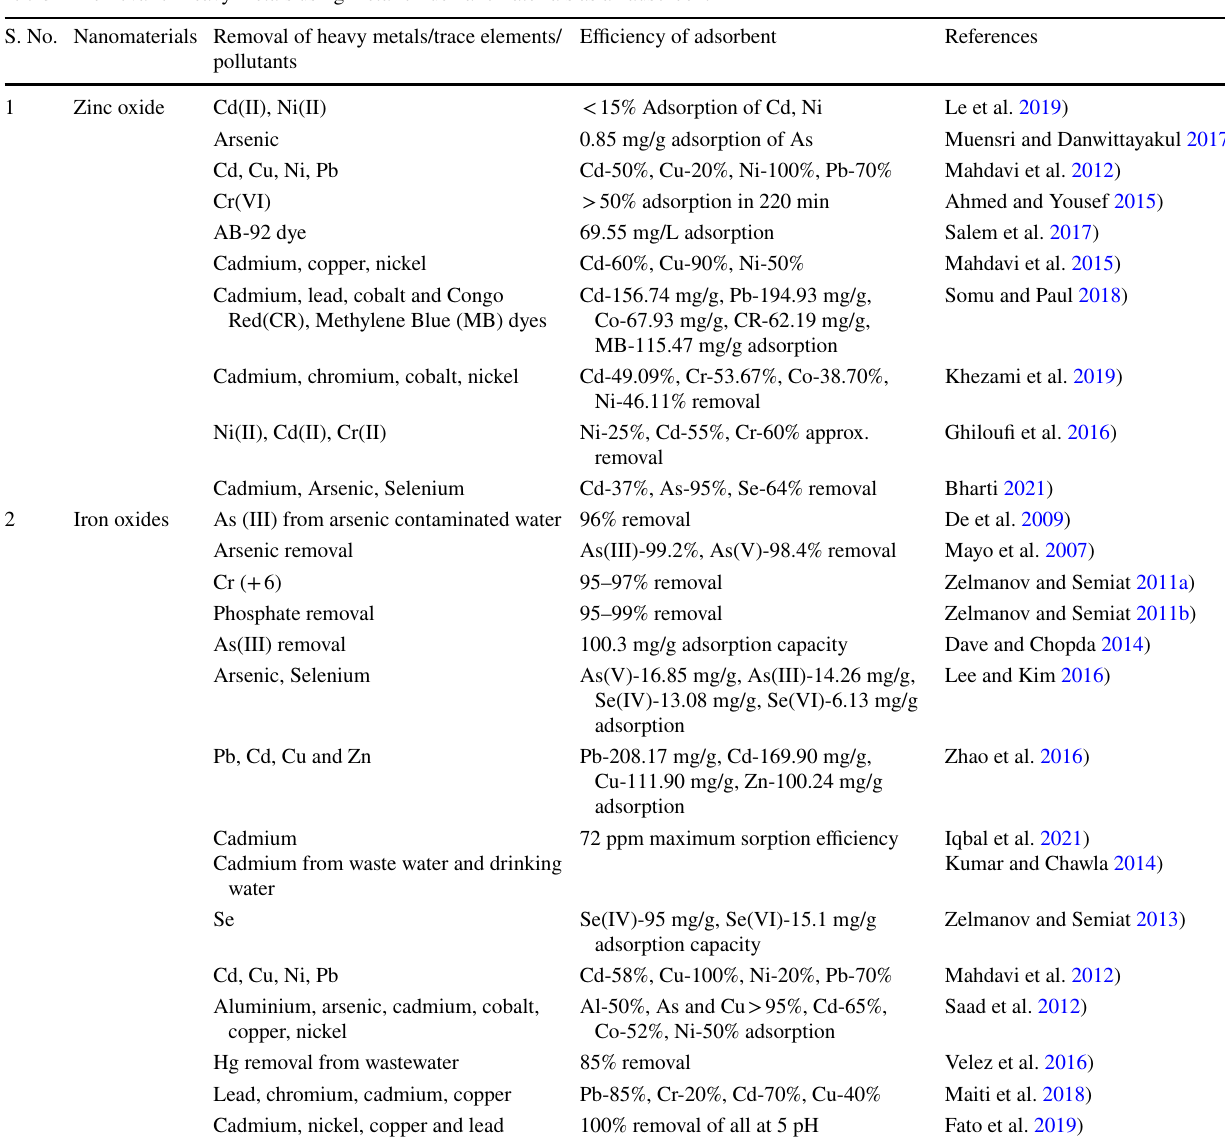
Table 1 Removal of heavy metals using metal oxide nanomaterials as an